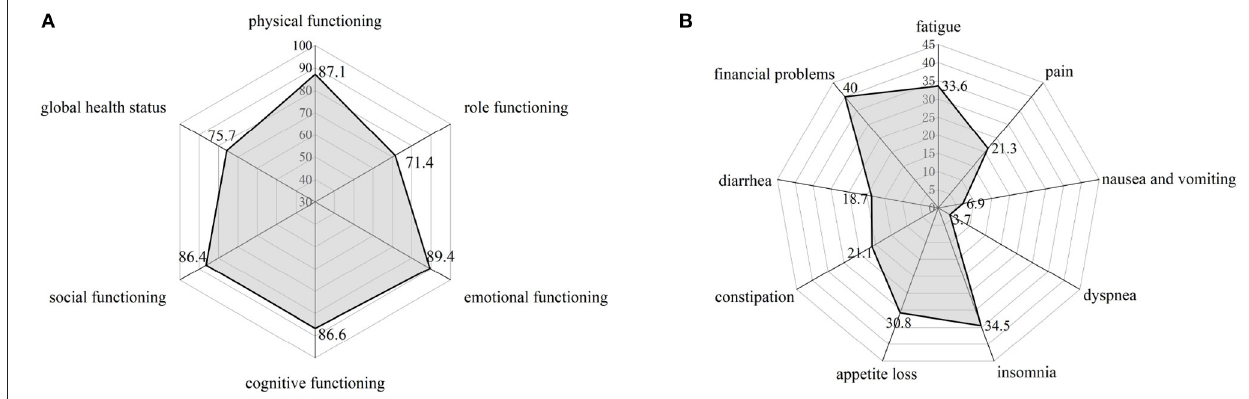
1 month after surgery, but lacked the long-term